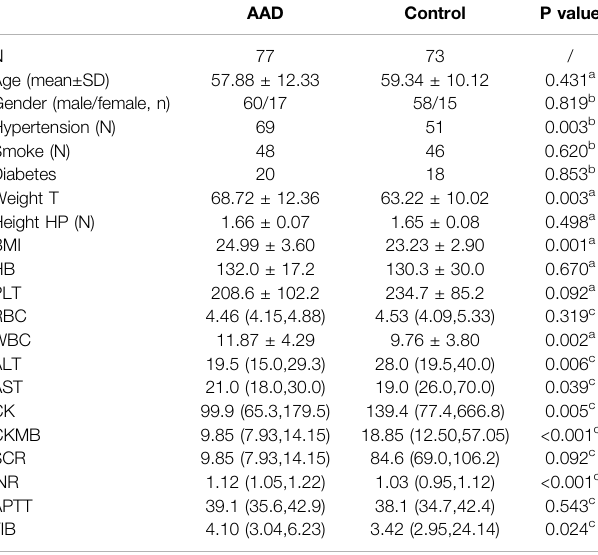
TABLE 2 | Clinical features of the validation analysis subjects.